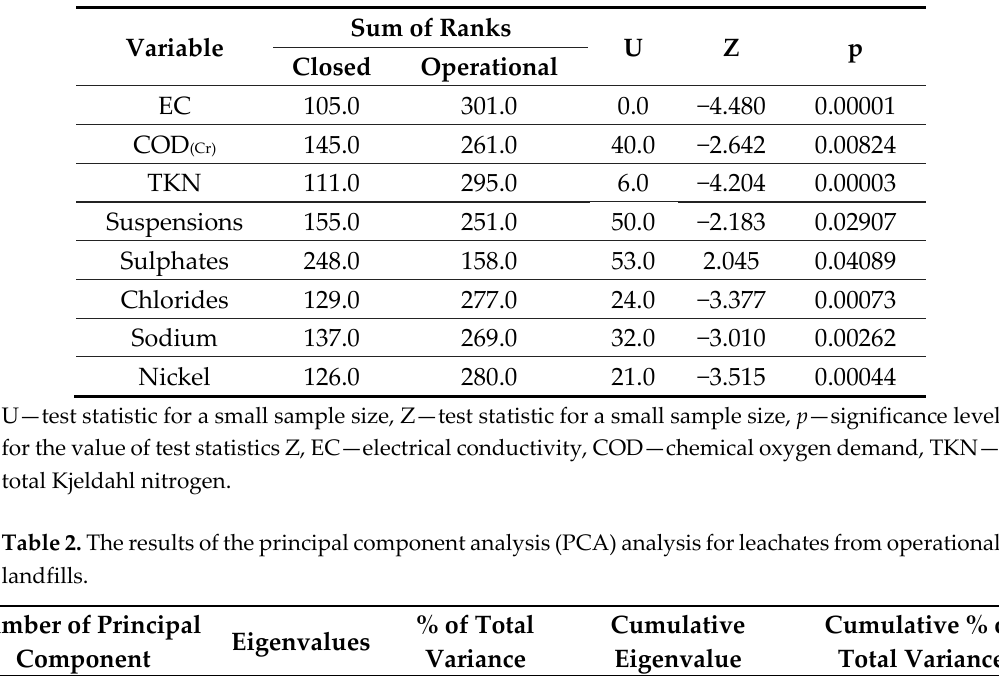
Table 1. Analysis of differences between the leachate composition of closed and operational landfills (the highlighted results are significant with p < 0.05).